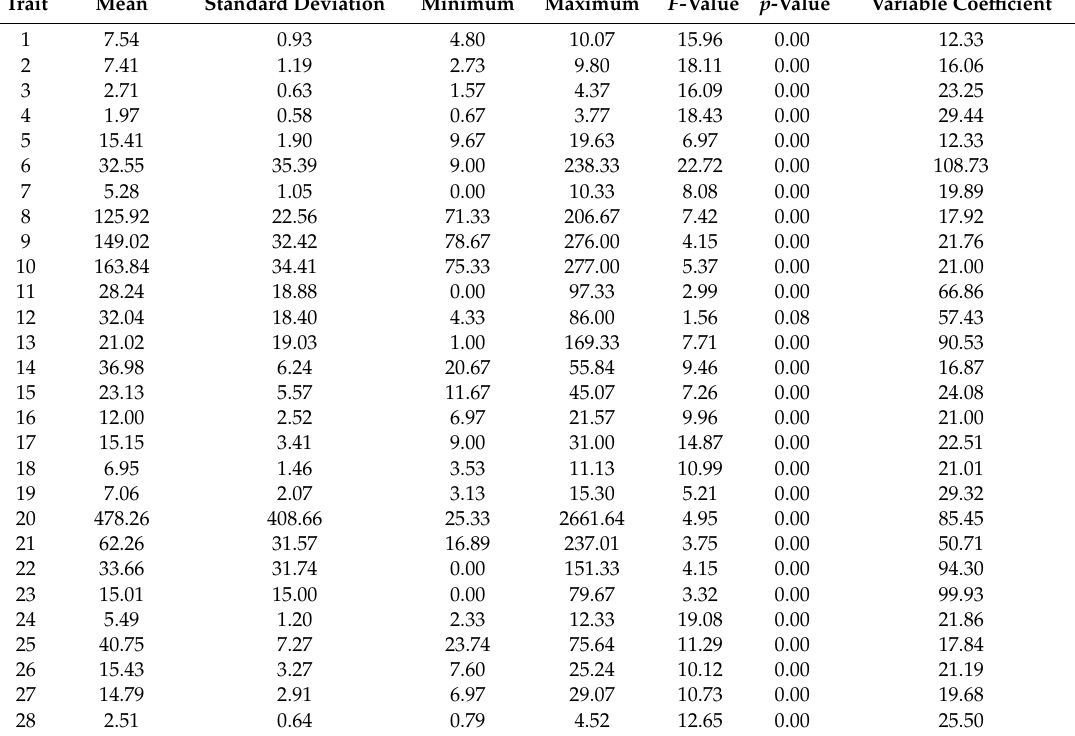
Table 4. Descriptive statistics for quantitative traits measured in 180